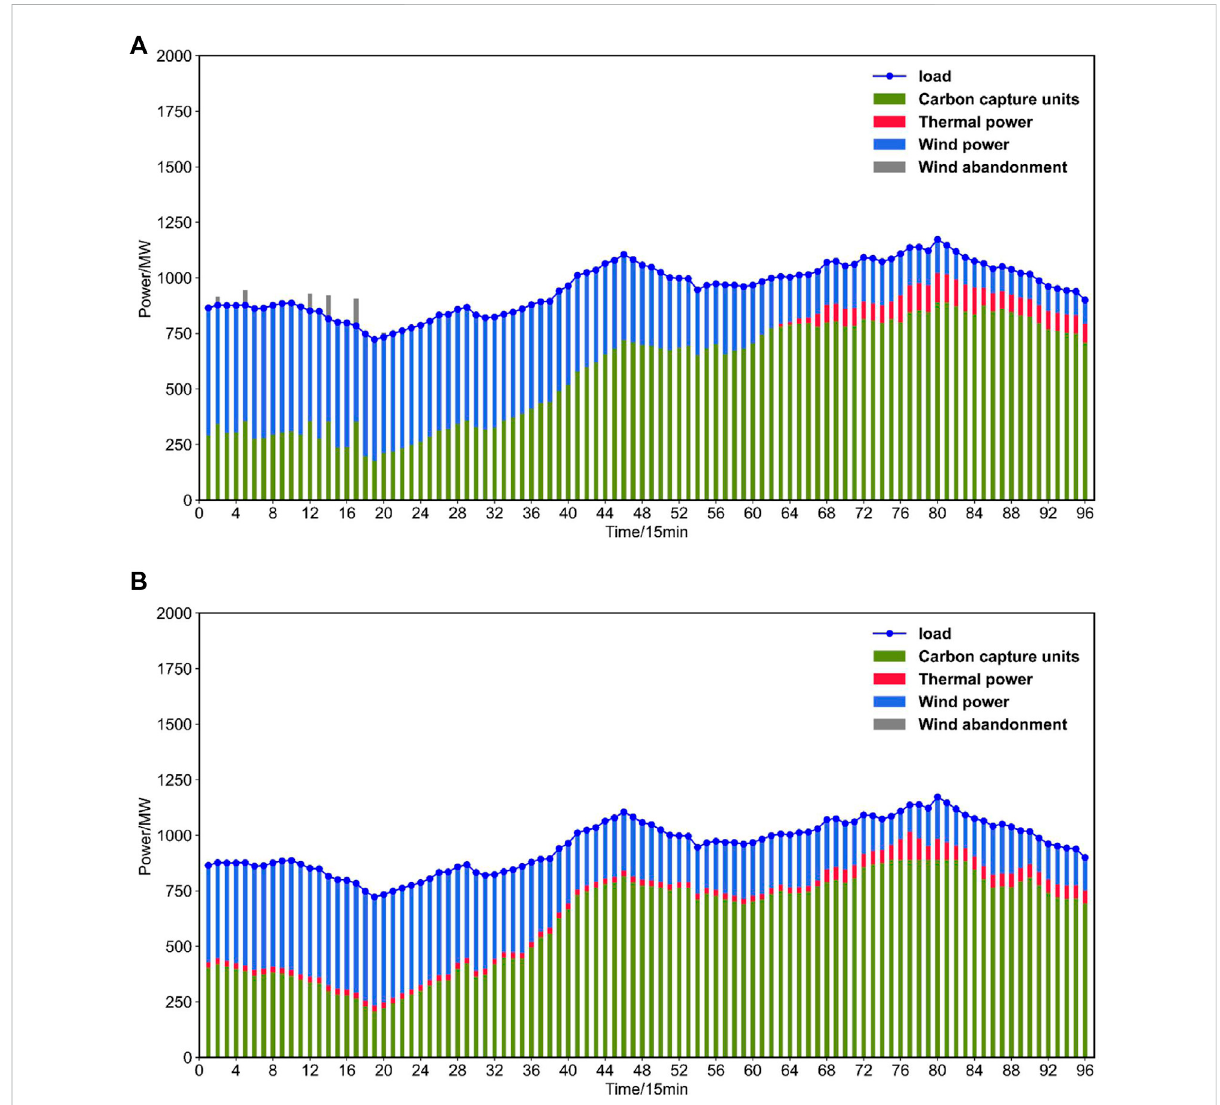
FIGURE 17 Intraday stage dispatch diagram ( (A) considering Belgian grid forecast wind power, (A) considering GRU forecast wind power).